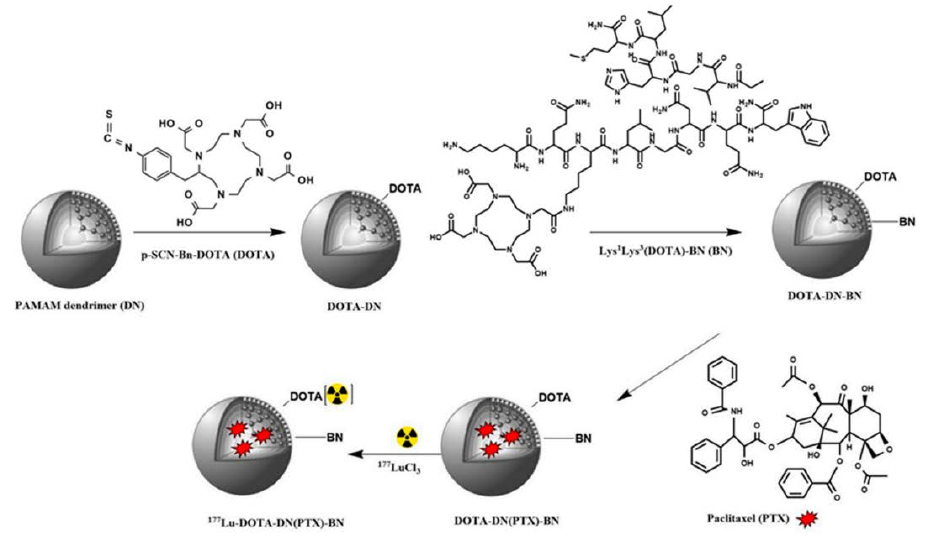
Figure 19. The synthetic procedures involved in the preparation of paclitaxel (PTX)-loaded PAMAM dendrimers conjugated with BBN and DOTA- 177 Lu. Reprinted from ref. [57].